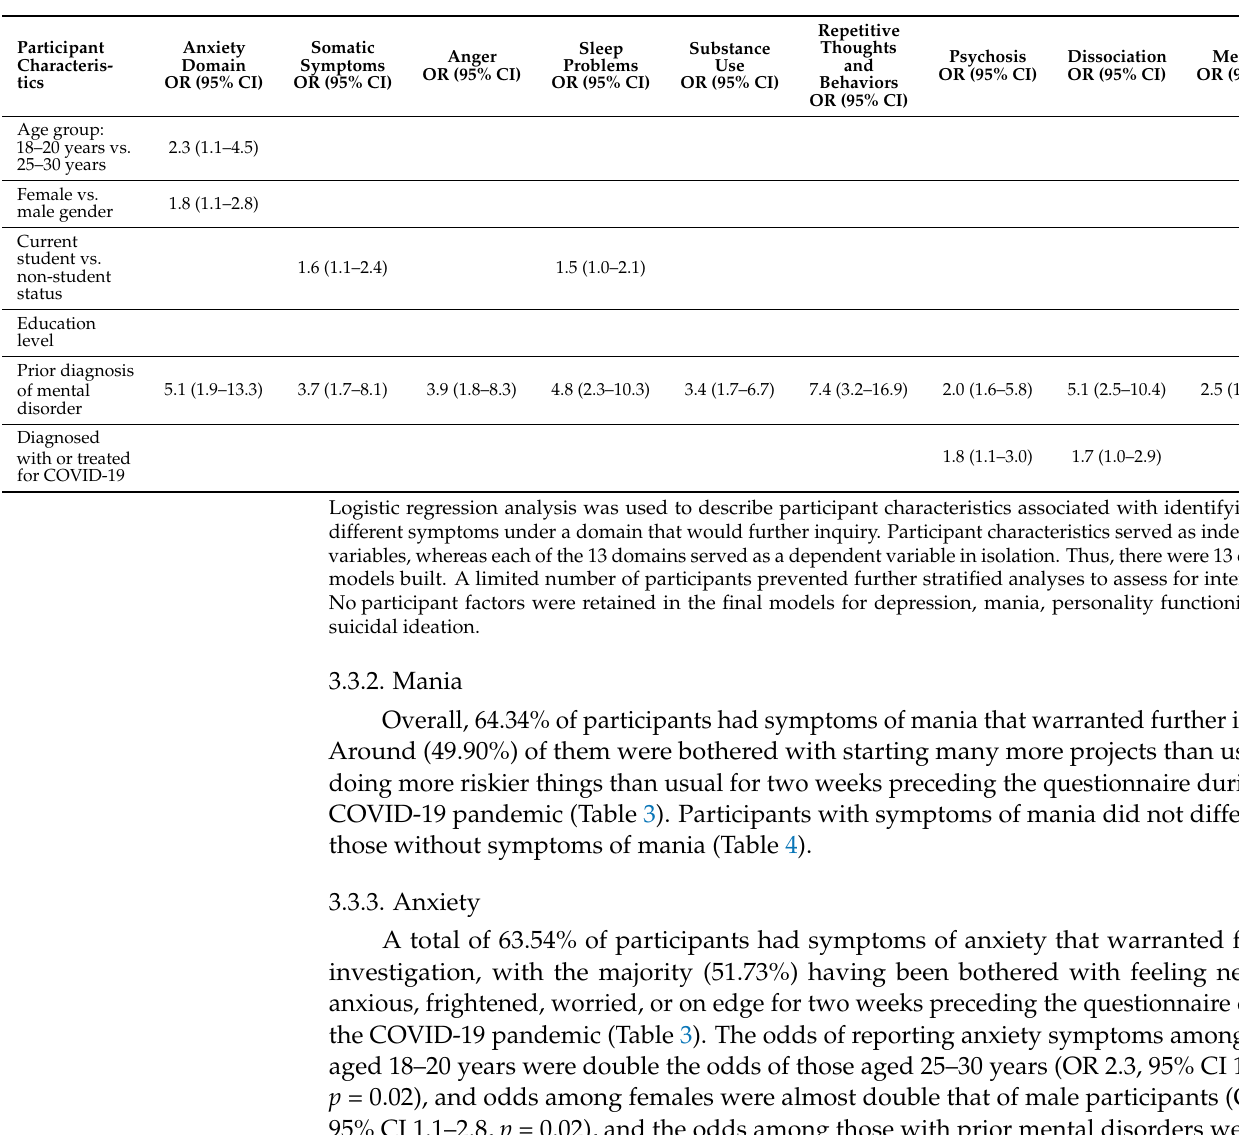
Table 4. Multivariate logistic regression showing significant factors associated with reporting symp- toms of mental disorders that warrant further inquiry, Saudi Arabia,